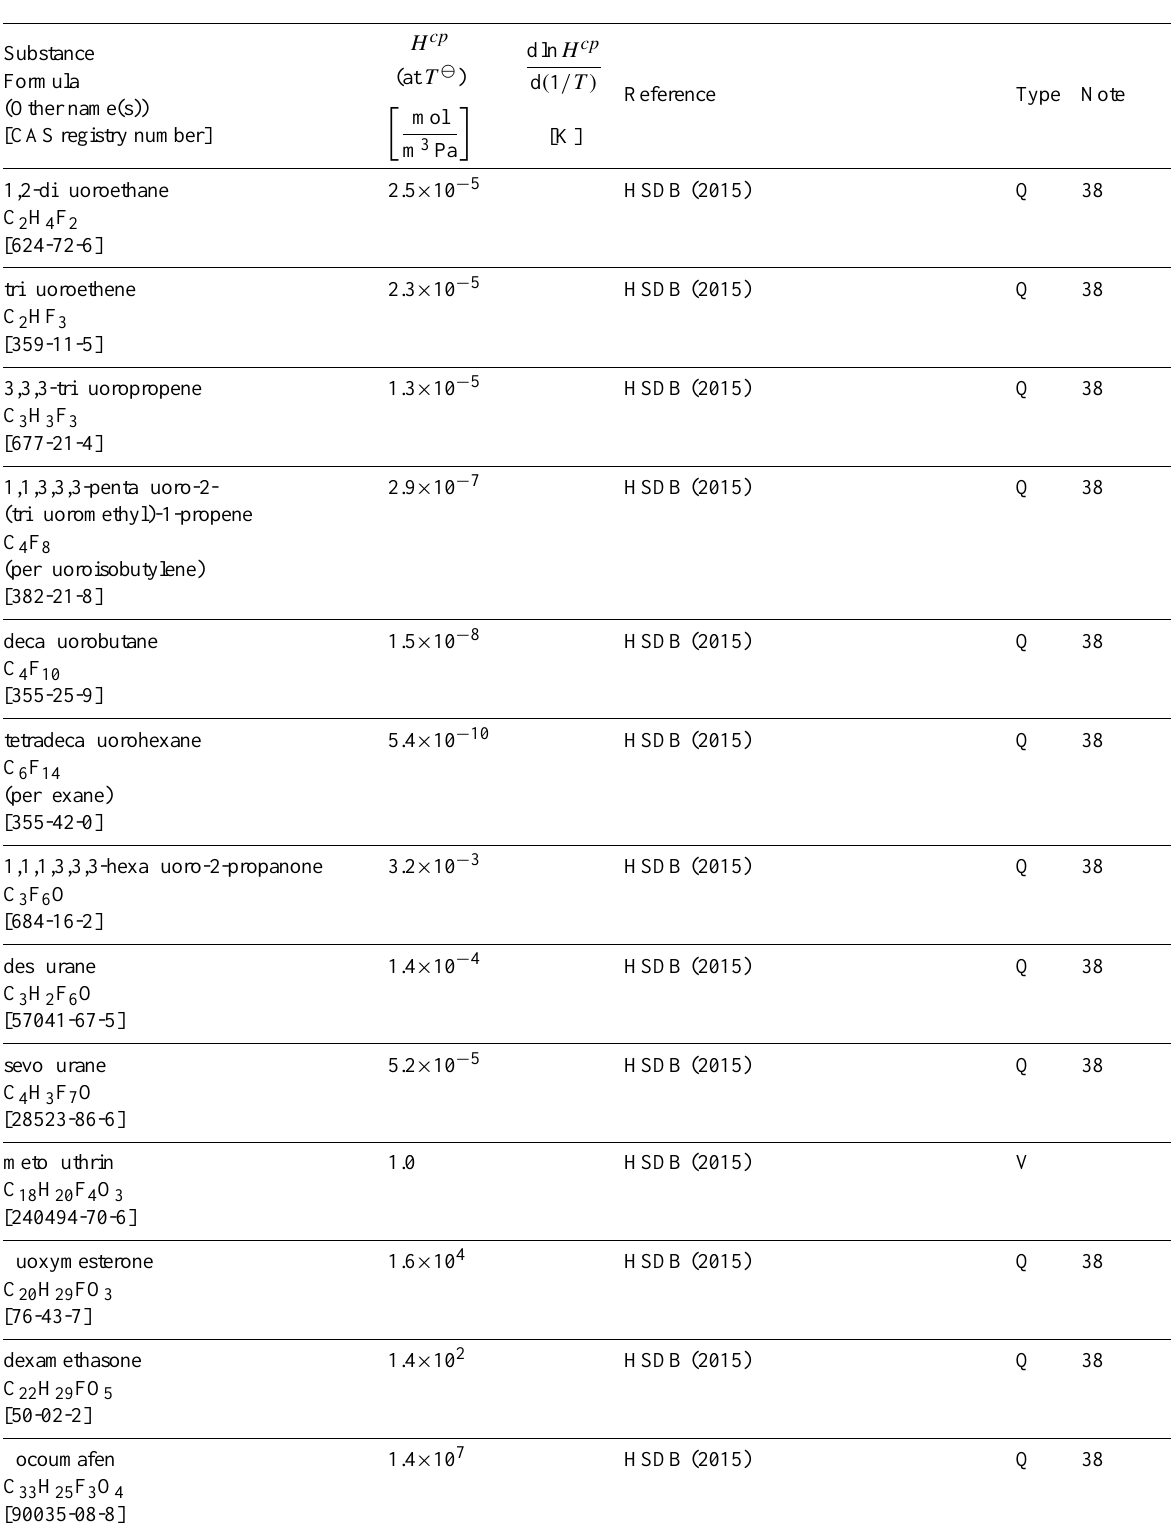
Table 6: Henry’s law constants for water as solvent